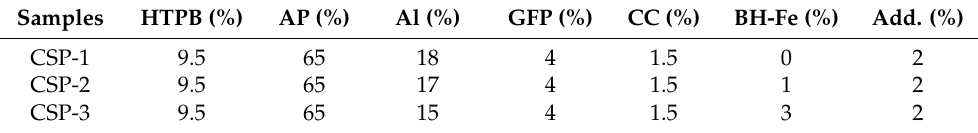
Table A4. Mass fraction of formulation’s compounds